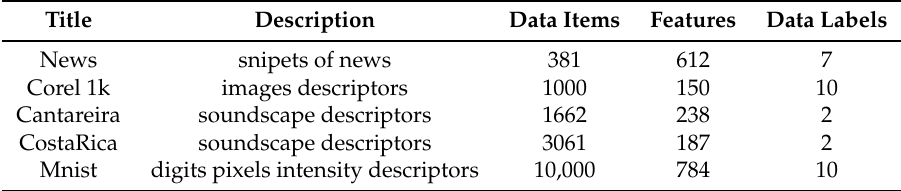
Table 1. Datasets used in the exploration of feature sets on graphs and trees.